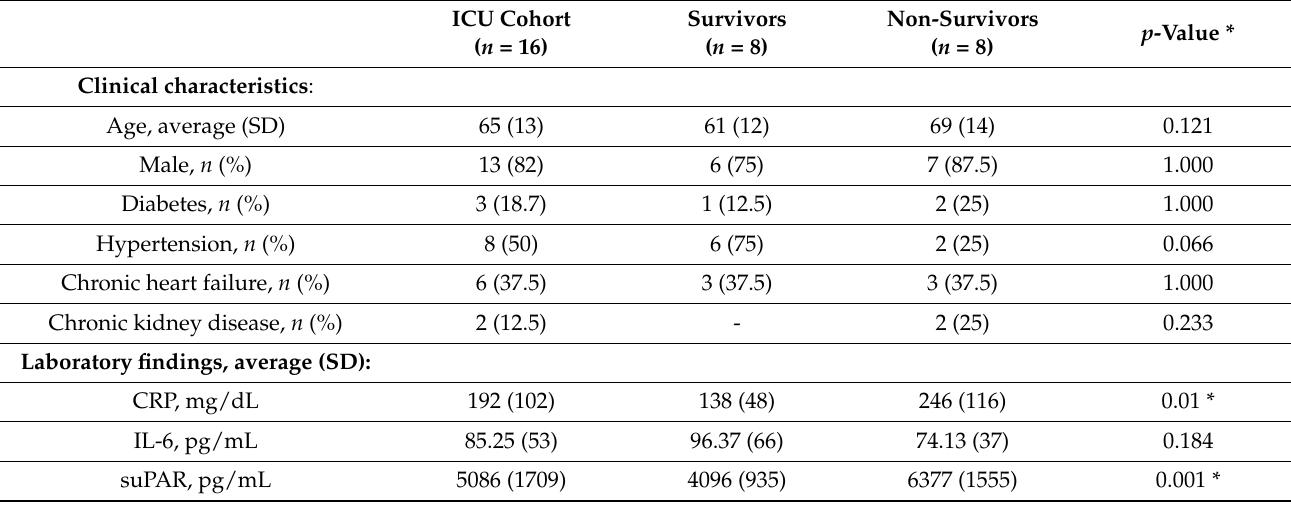
Table 4. Clinical characteristics and laboratory data of ICU patients during the Italian first wave.